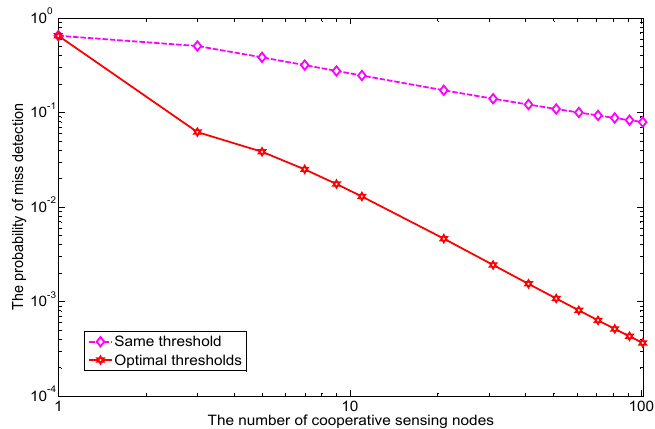
Figure 7. The probability of miss detection for two different thresholds methods are shown with the increasing number of cooperative sensing nodes; the target P f = 1%.